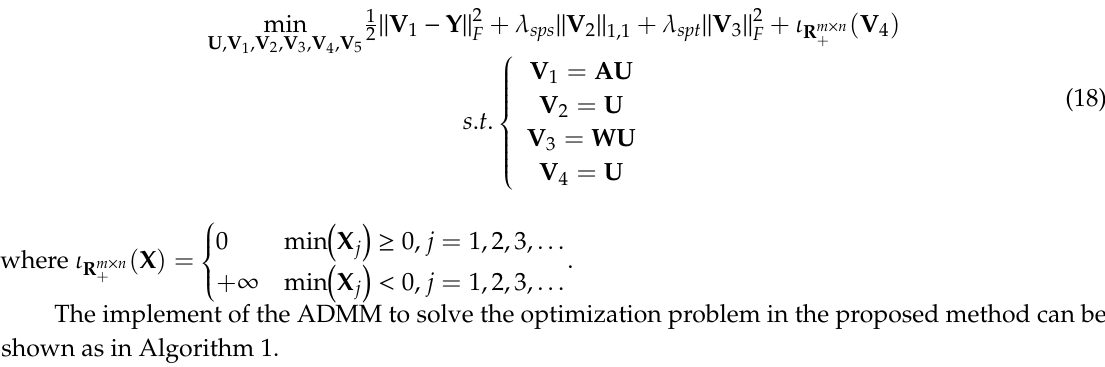
Algorithm 1: Pseudocode of the proposed method